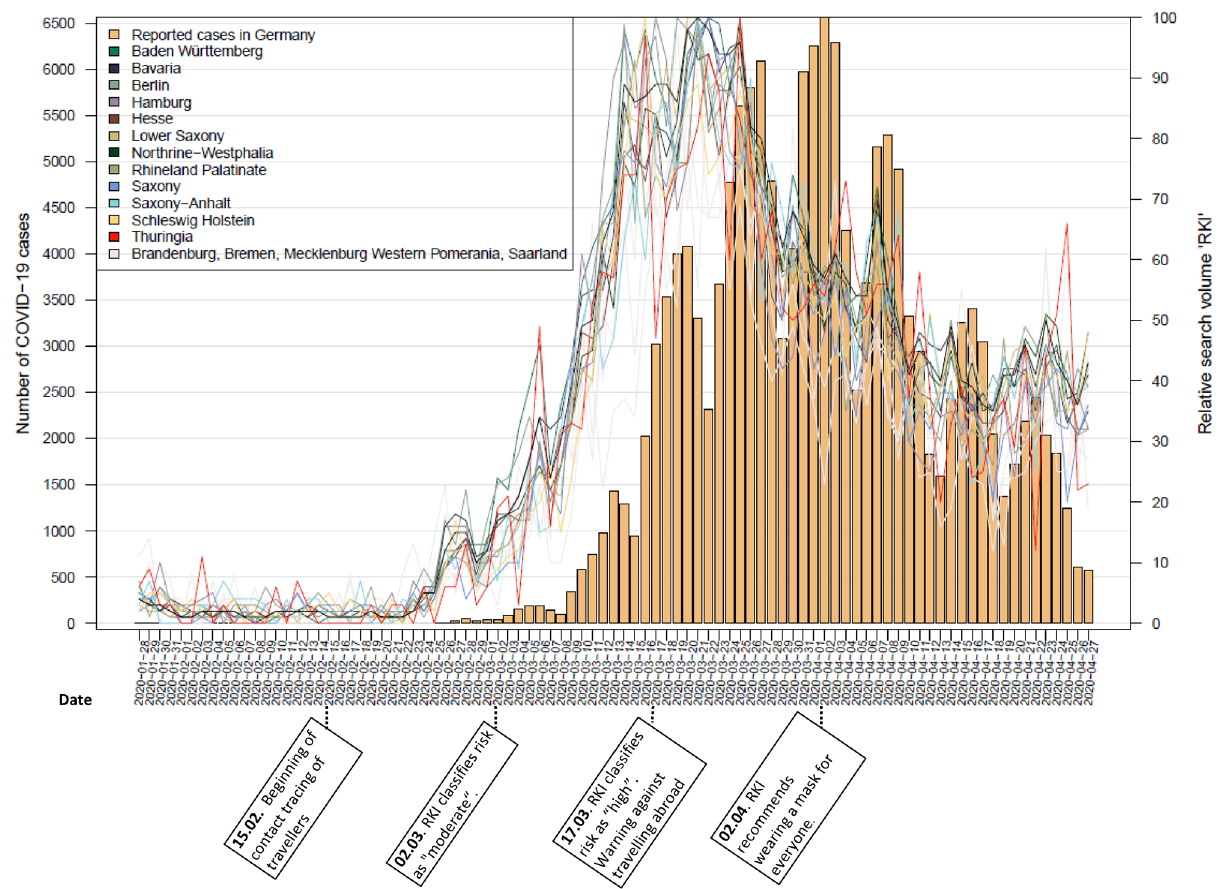
Figure 2. Nationally reported COVID-19 cases and RSV for the search term ‘RKI’ at state